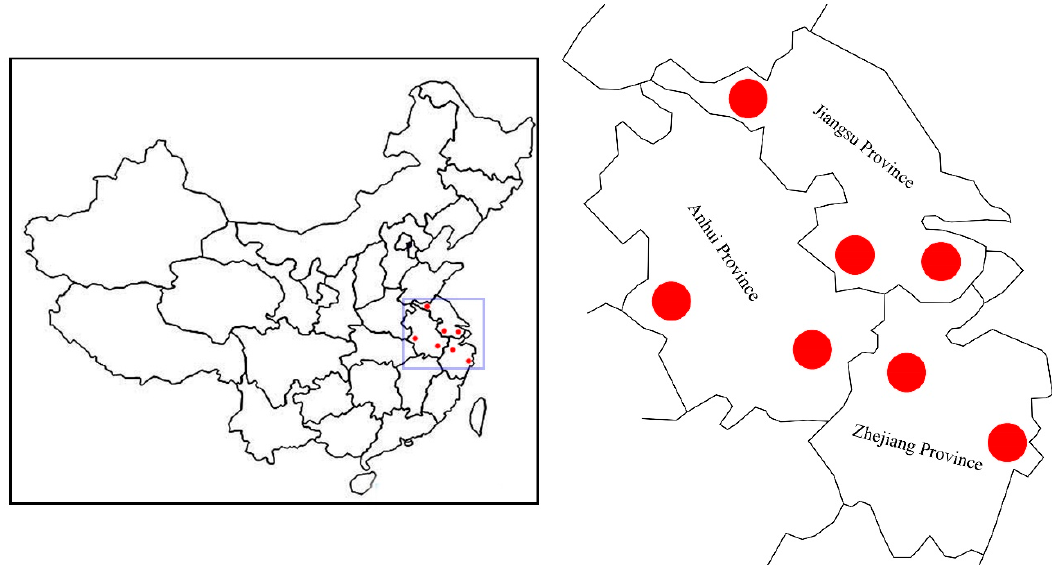
Figure 1. Map showing locations of the populations of Chinese elm.